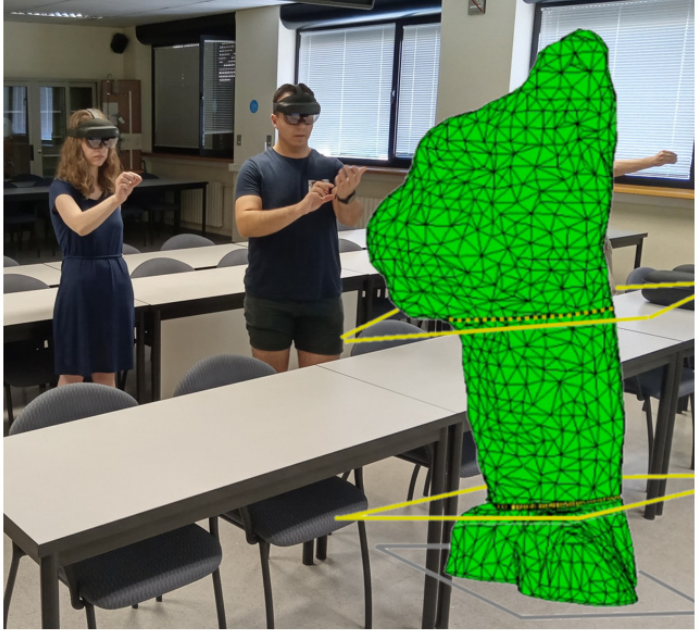
Figure 21. “Cadireta” (Montserrat): MR visualization concept for inspection of the FEM mesh. To highlight the two siltstone layers (in yellow), several planes have been added to the scene.